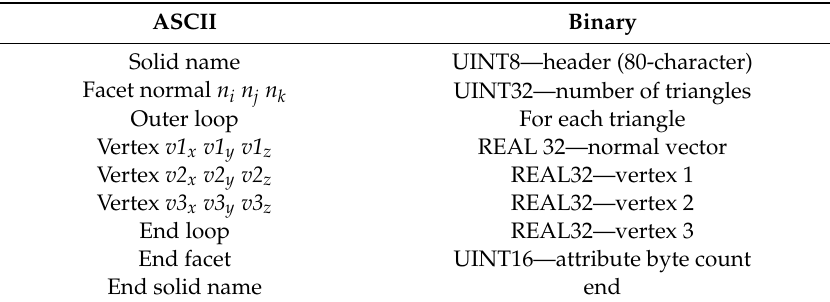
Table 1. Stereolithographic model format.